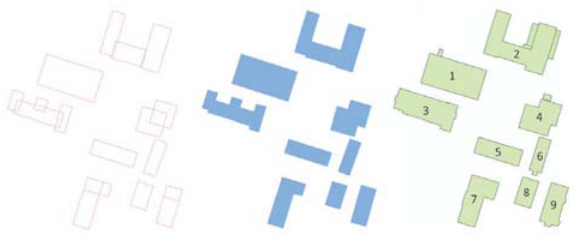
Figure 6. Footprint reconstruction of a scene with multiple buildings: the extracted primitives (left), reconst- ructed footprints (middle), and the ground truth data (right) from cadastral map as reference